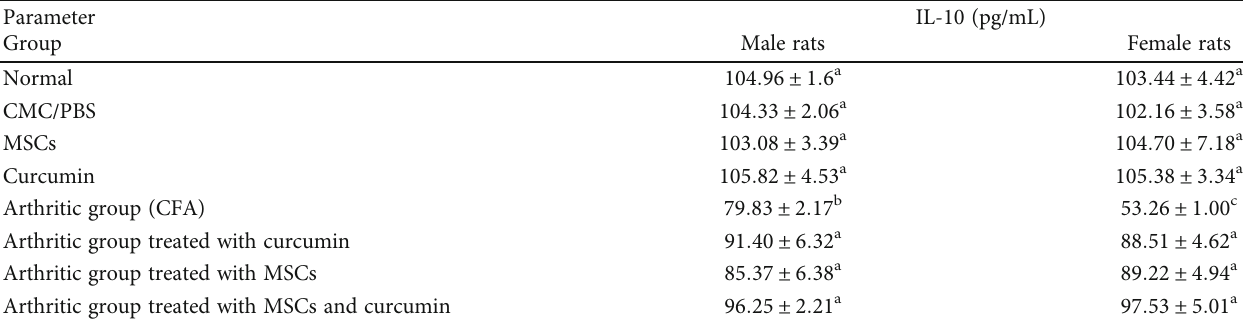
Table 6: E ff ect of MSCs and curcumin on serum IL-10 (pg/mL) level in arthritic